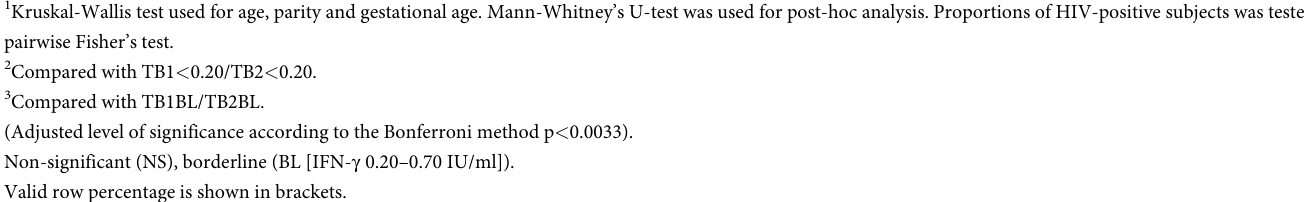
Table 5. Characteristics of women with regard to QFT-Plus results in the borderline interval (0.20–0.70 IU/ml).